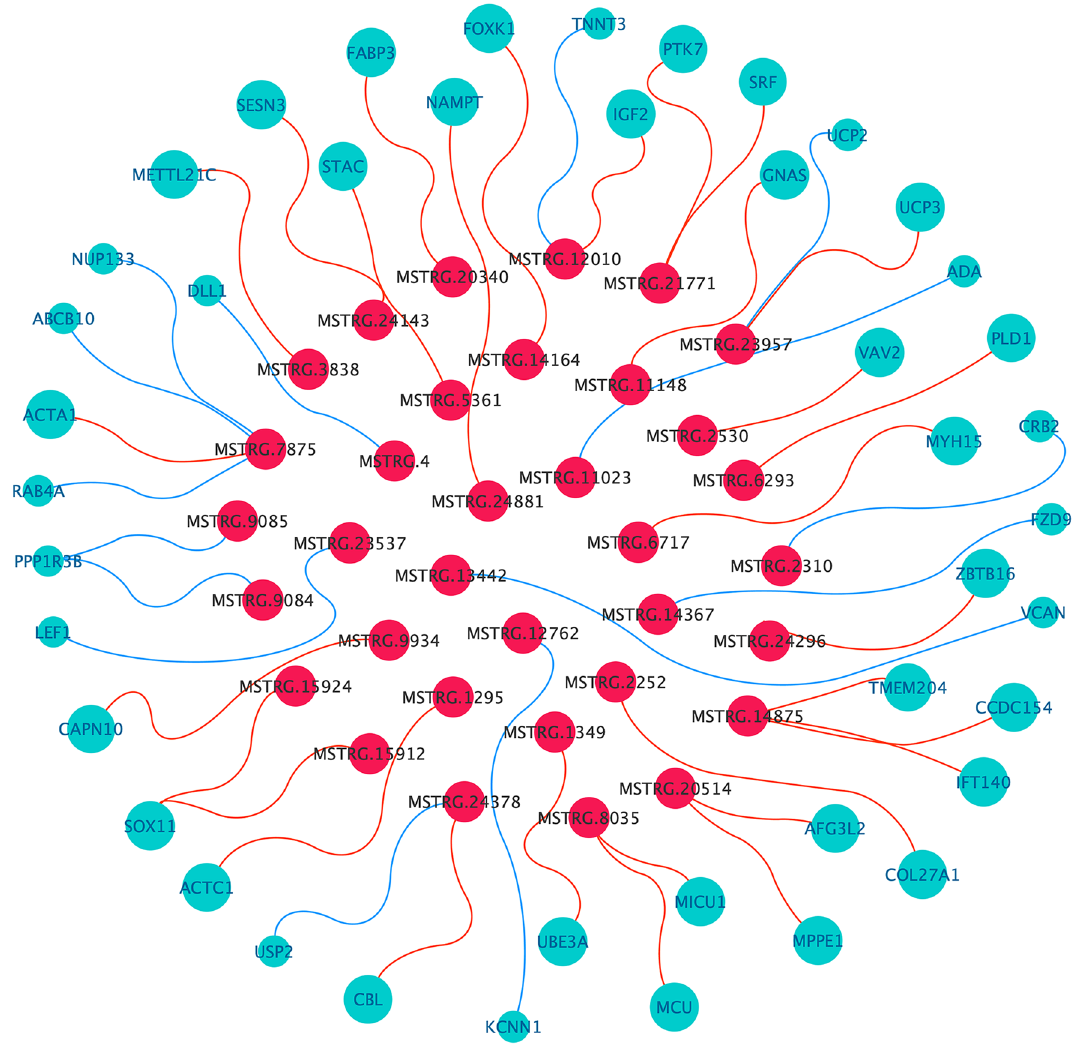
Figure 6. DELs-MDRPTGs co-expression network diagram. Green dots represent MDRPTG, red dots represent DEL; green lines indicate that DEL is negatively correlated with the corresponding MDRPTG, and red indicates that DEL is positively correlated with the corresponding